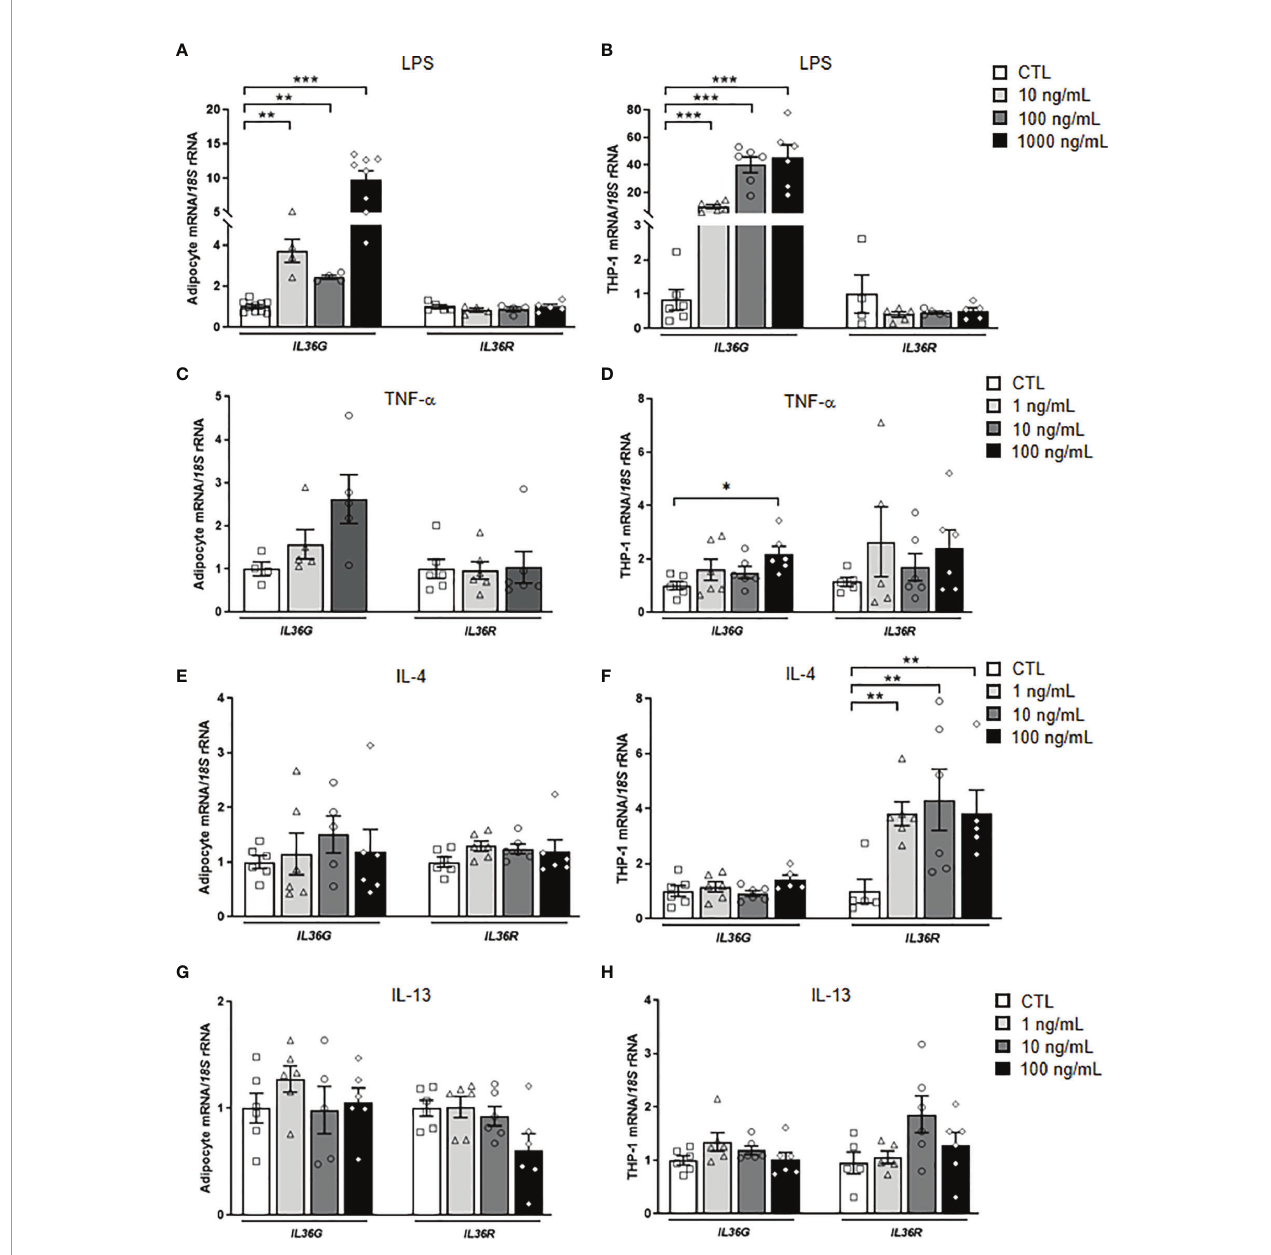
FIGURE 2 | Effects of in fl ammation-related factors on IL36G and IL36R gene expression levels. Bar graphs show the effect of (A, B) LPS, (C, D) TNF- a , (E, F) IL-4 and (G, H) IL-13 incubated for 24 h on the transcript levels of IL36G and IL36R in human differentiated visceral adipocytes and monocyte-derived macrophages. Gene expression levels in unstimulated cells were assumed to be 1. Values are the mean ± SEM (n=4-7 per group). Differences between groups were analyzed by one-way ANOVA followed by Dunnetts ’ s tests. * P < 0.05, ** P < 0.01 and *** P <